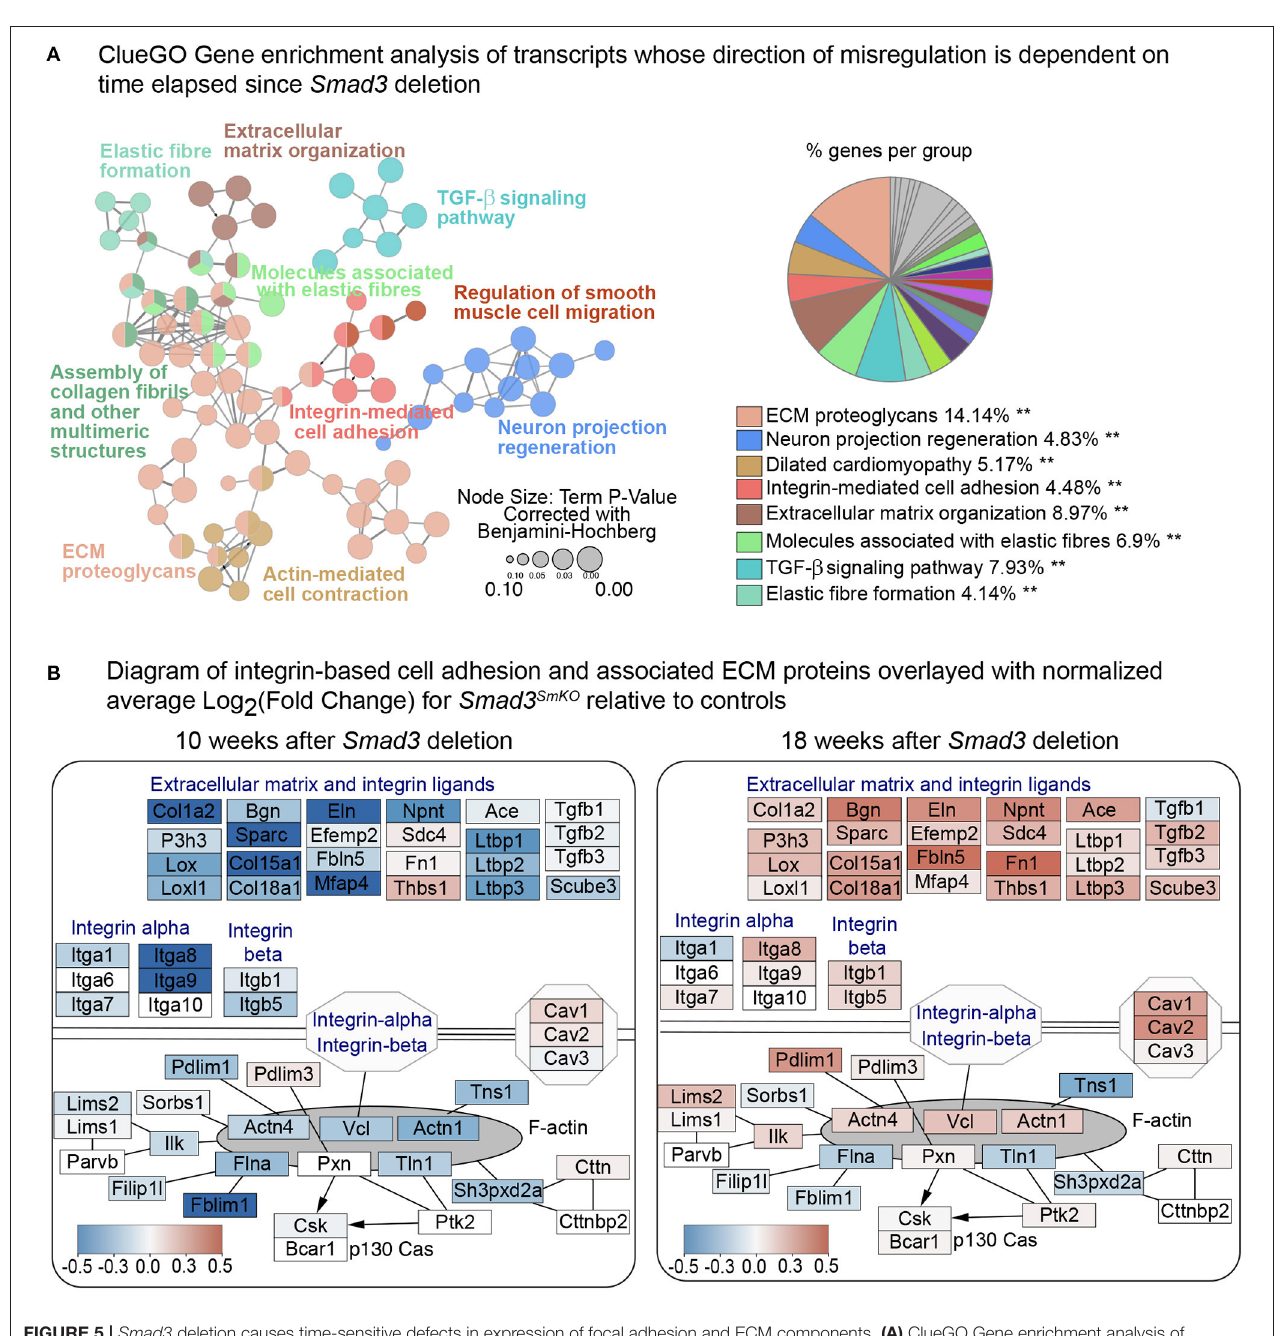
FIGURE 5 | Smad3 deletion causes time-sensitive defects in expression of focal adhesion and ECM components. (A) ClueGO Gene enrichment analysis of transcripts whose direction of change in Smad3 SmKO relative to controls is dependent on time elapsed since Smad3 inactivation. 153 transcripts had a negative Log 2 FC 10 weeks after Smad3 deletion, but a positive Log 2 FC at 18 weeks, and 105 showed the opposite behavior, for a total of 258 transcripts displaying a time-sensitive transcriptional dysregulation upon Smad3 deletion. Each node represents a group of genes sharing a similar function. The color of the node corresponds to a ClueGO functional group to which each node belongs. Nodes belonging to more than one ClueGO functional group are filled with multiple colors. Asterisks indicate significance as calculated by ClueGO algorithm and corrected using the Benjamini-Hochberg method for multiple testing correction. (B) Custom pathway diagram adapted from WikiPathways WP523, WP6, WP85 and WP113 using the PathVisio 3.0 software, and overlayed with relative expression data using Cytoscape. Each node shows expression of transcripts coding for extracellular matrix components, integrin ligands, integrins, and intracellular focal adhesion components in VSMCs 10 weeks and 18 weeks after Smad3 deletion. Genes shown in blue are downregulated and genes shown in red are upregulated in Smad3 SmKO relative to controls. Scale indicates the average Log 2 FC in expression.